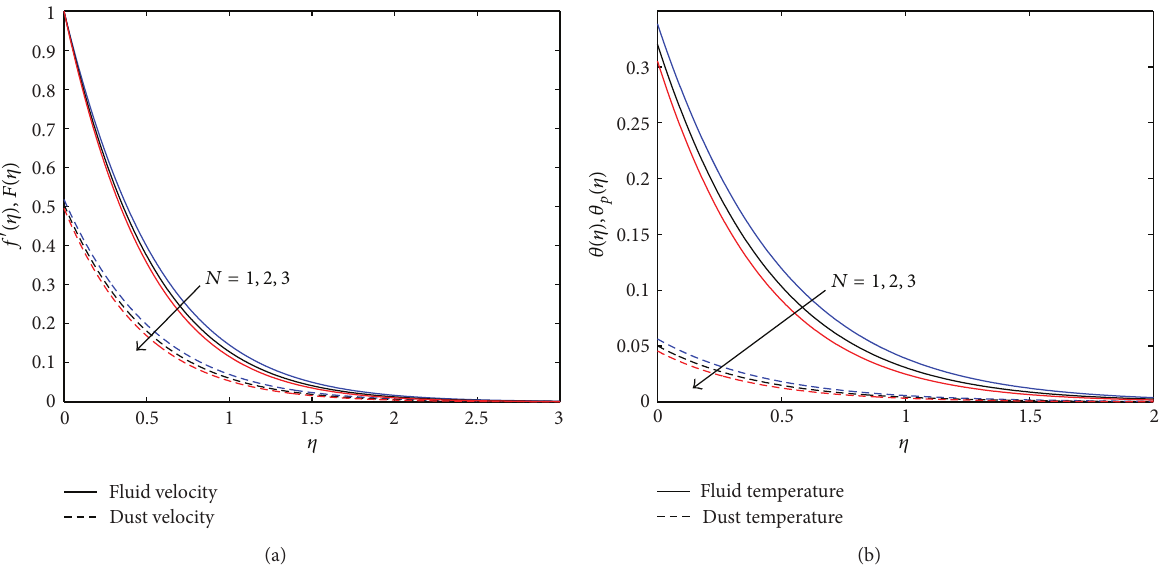
Figure 7: Effect of 𝑁 on (a) 𝑓 󸀠 , 𝐹 and (b) 𝜃 , 𝜃 𝑝 when 𝑀 = 1 , 𝑆 = 2 , Ec = 0.1 , 𝛽 ℎ = 1 , and Bi = 1